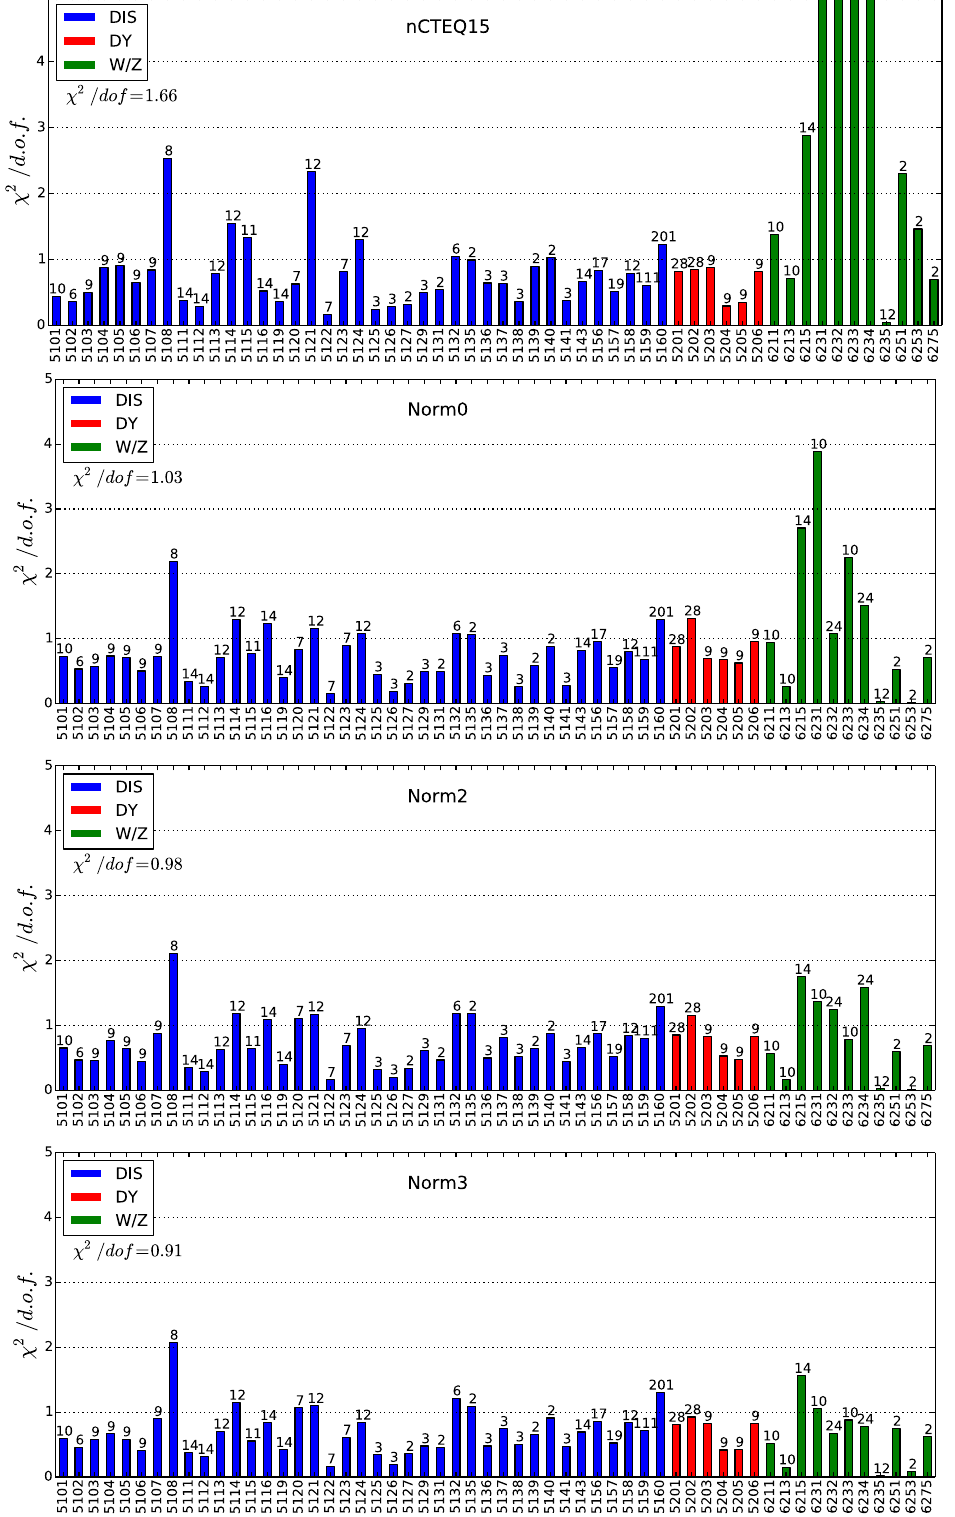
Fig. 2 The χ 2 / N dof of the individual experiments. The number of data points is indicated at the top of the bar, and the total χ 2 / N dof for the entire set is shown below the legend. For the nCTEQ15 set,